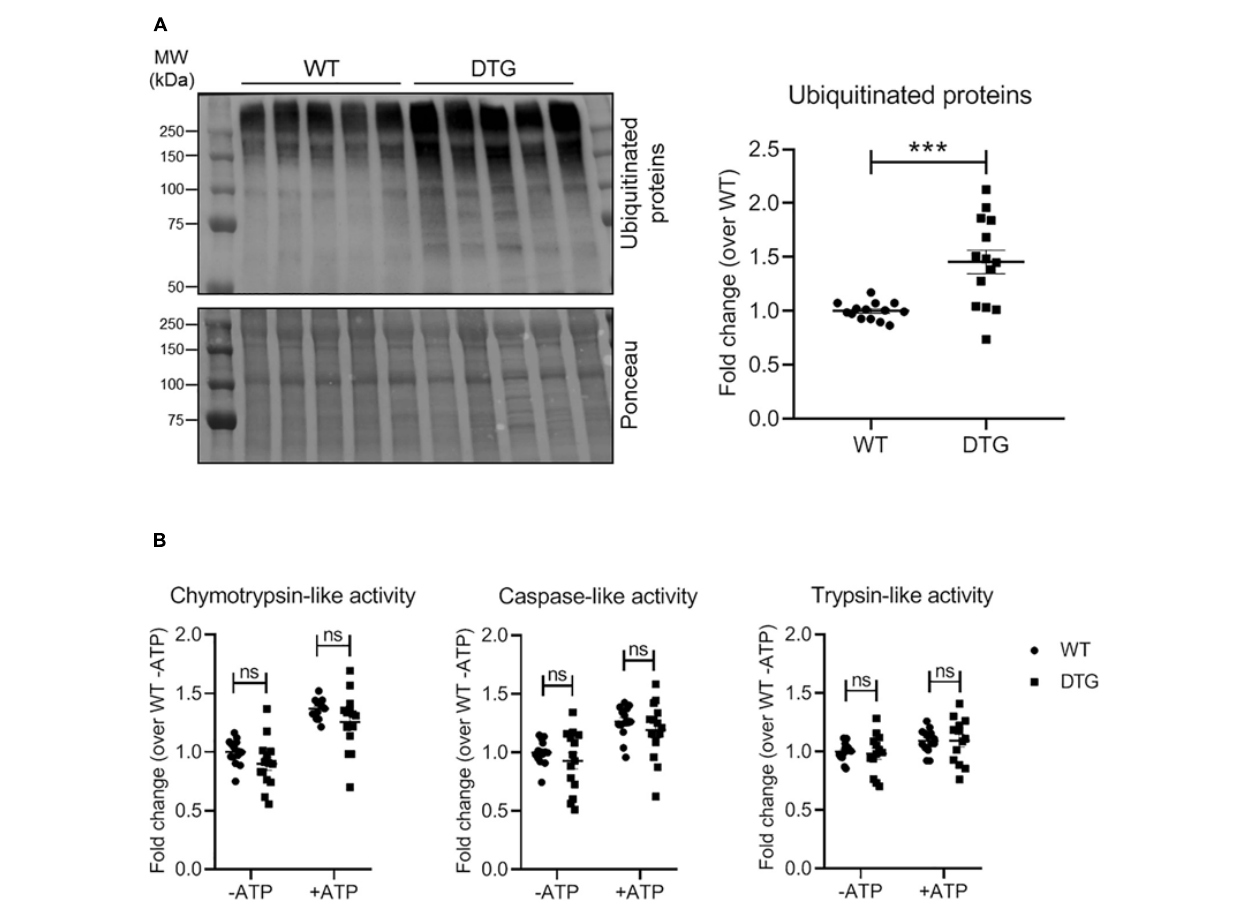
FIGURE 3 | Steady-state levels of ubiquitinated proteins and proteasomal activities in DTG and WT mice. (A) Representative Western blot and quantification of the steady-state levels of ubiquitinated proteins normalized to Ponceau and related to WT. (B) 20S (ATP-independent) and 26S (ATP-dependent) chymotrypsin-like, caspase-like and trypsin-like activities were measured by using specific fluorogenic substrates. Data are presented as mean ± SEM with *** p < 0.001 vs. WT and ns = non-significant, unpaired Student’s t -test. N =